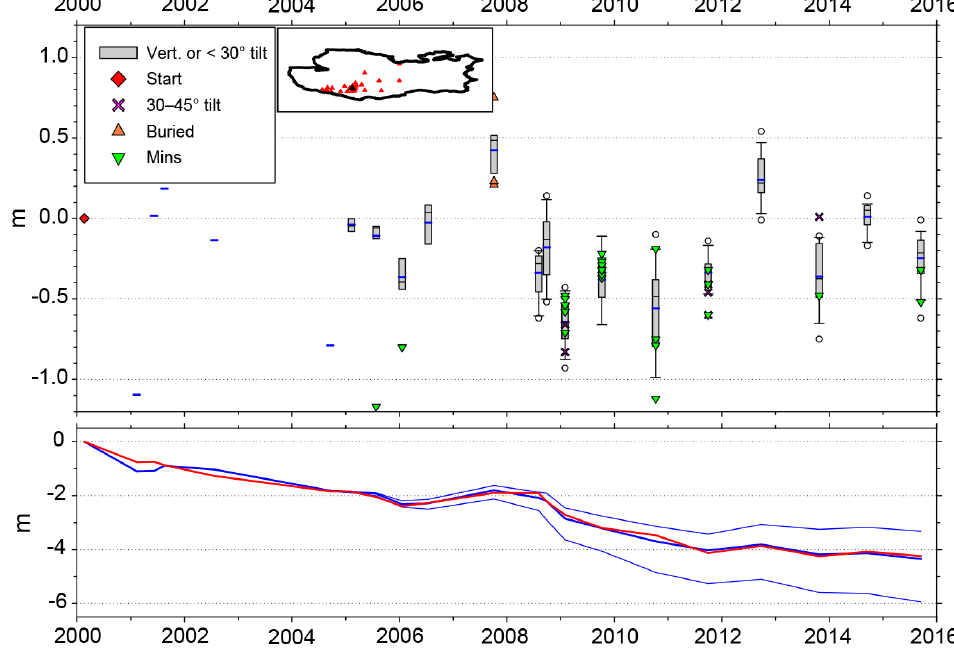
Figure 5. Ice surface elevation change at NIF derived from ablation stakes with at least two consecutive measurements (increasing from n = 1 to n = 19 stakes, in 2000 and 2015, respectively). The AWS and spatial coverage of stakes at NIF are shown next to the legend in the upper left (black and red triangles, respectively). In the top plot, grey box plots represent the distribution or change in ice height (median, quartiles) at vertical or near-vertical stakes ( < 30 ◦ tip; height measured along stake). Thick horizontal blue markers show the mean height change or height change values for only one measurement (i.e. 2001–2004). When the sample size is big enough, outliers are shown as black circles above/below the box plot whisker caps (90th and 10th percentiles). Stakes leaning 30–45 ◦ , buried by accumulation, and those lying down due to ablation are shown as “x”, orange and green inverted triangles, respectively; inverted triangles are thus minimum estimates of surface lowering. The lower plot shows cumulative ice height changes based on medians (thick blue line) and quartiles (thin blue) of the box plot data set. Also shown (red line) is cumulative height change at the AWS; any snow overlying the ice is included in these heights (e.g. February 2001), accounting for some of the apparent